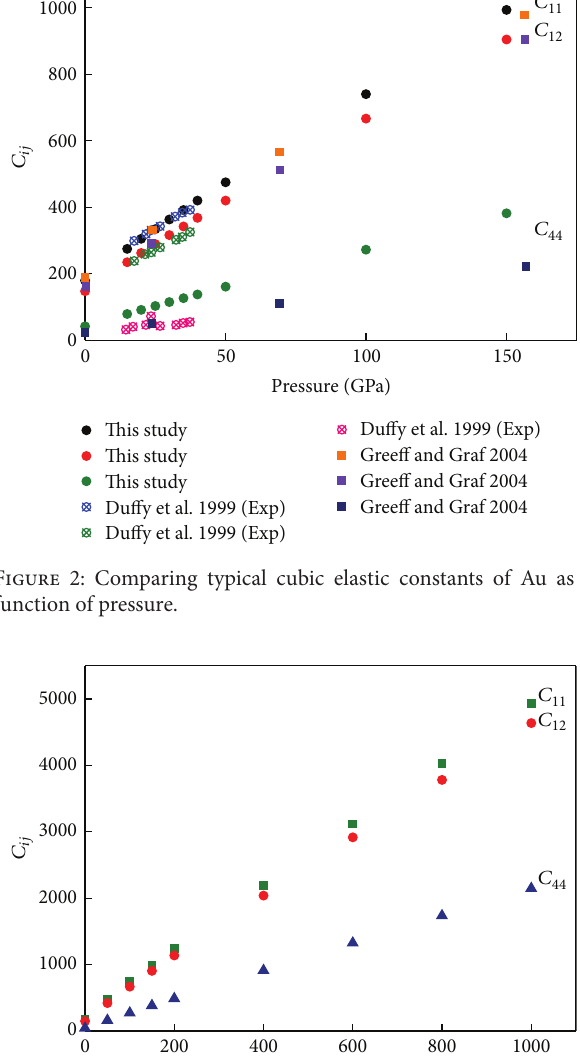
Figure 5. Under high pressure both of the sound